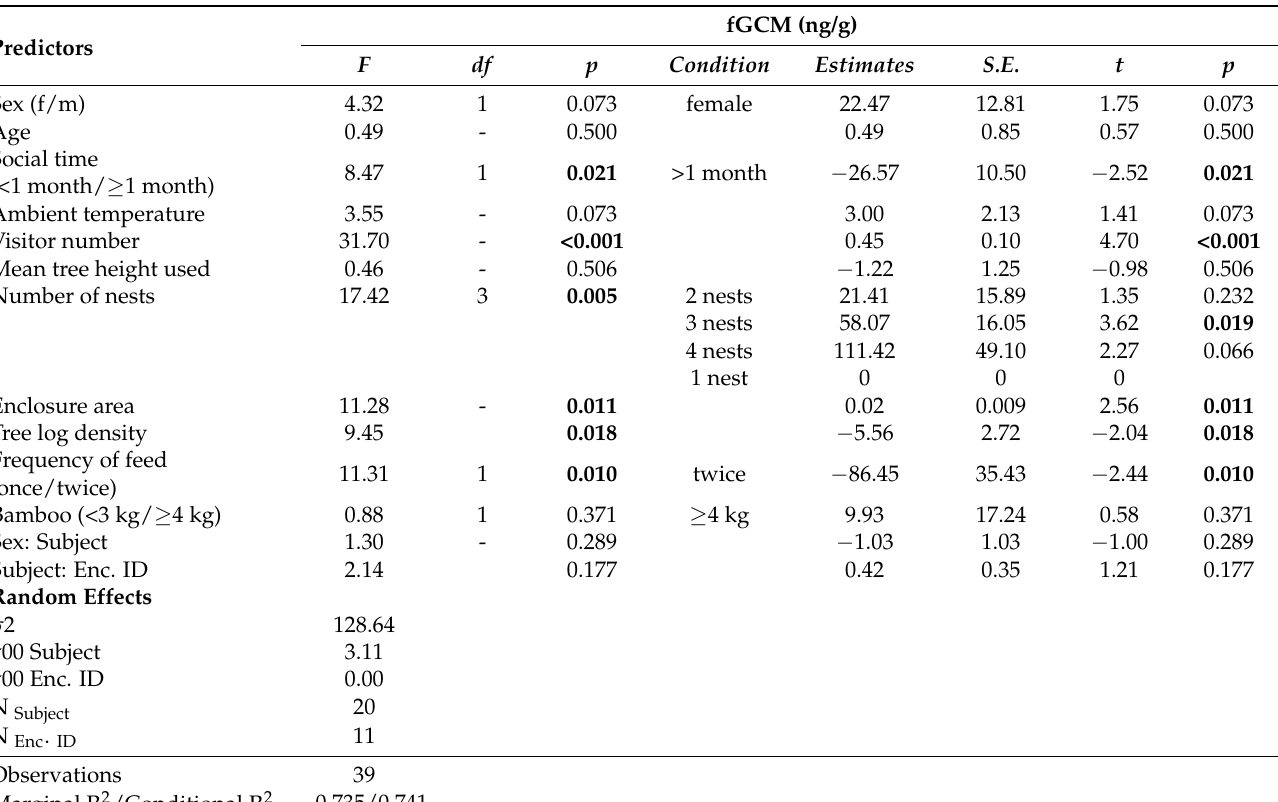
Table 2. Generalized linear mixed model (GLMM) analysis of the effect of biological and environ- mental covariates on fecal glucocorticoid metabolites (fGCM) of captive red pandas at three Indian zoos. Significant differences are in